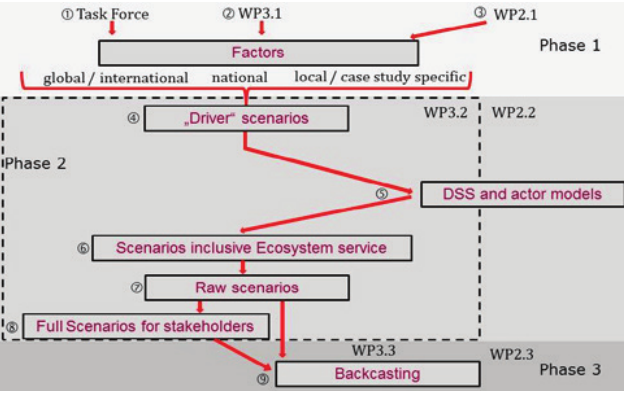
Fig. 1. The general workflow of the INTEGRAL project (Phase